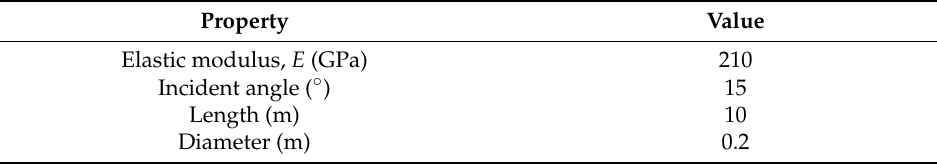
Table 3. Main properties of soil nailing.